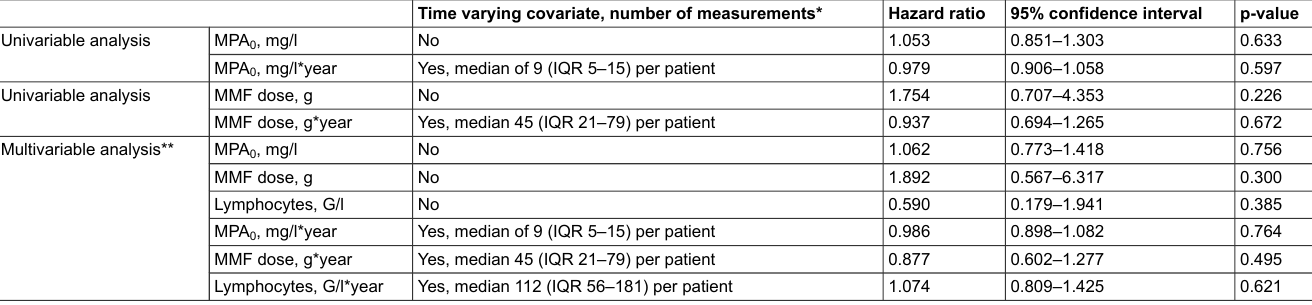
Table 2: Univariable and multivariable event-time-analytical Cox proportional-hazards regression model in 71 patients with chronic lung allograft dysfunction (34 events) as the outcome. Time varying covariate, number of measurements* Hazard ratio 95% confidence interval p-value